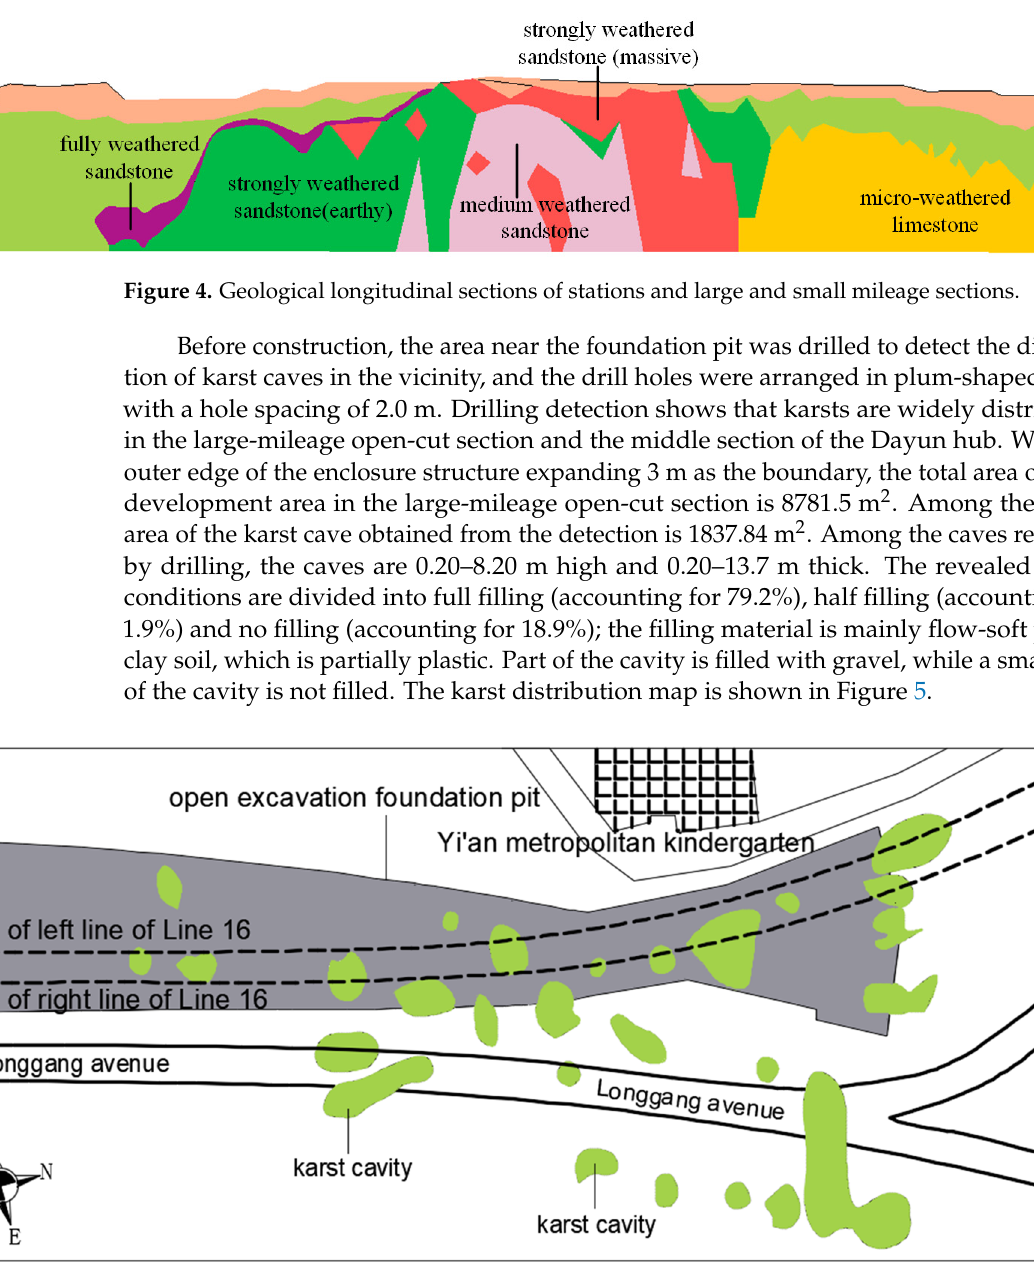
Figure 5. General plan of karst distribution in large-mileage open-cut section.